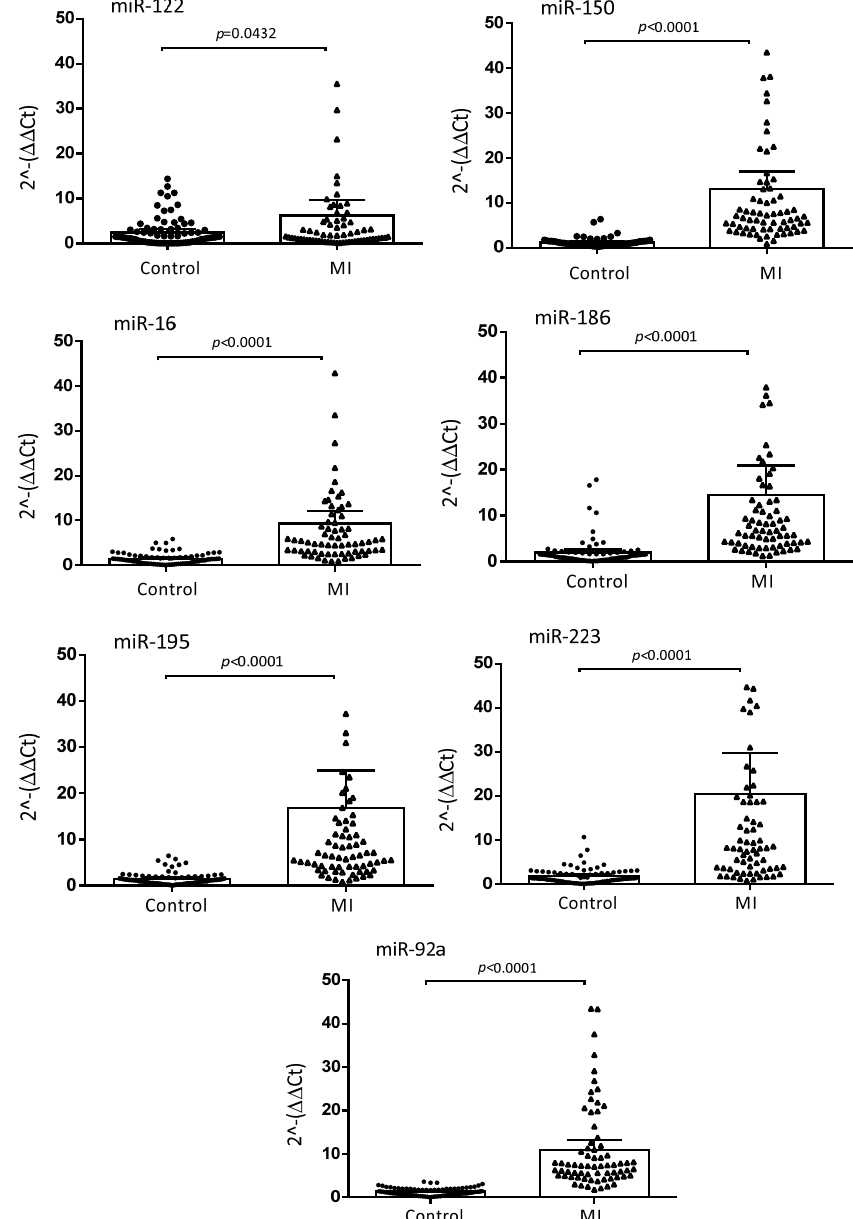
Figure 1. Relative expression of plasma miRNA levels in MI and control populations. The ΔΔ Ct method was used to quantify the relative miRNA expression of miR-122, miR-150, miR-16, miR-186, miR-195, miR-223 and miR-92a. Ct values were normalized to cel-miR-39-3p and cel-miR-39-5p and the relative expression of the miRNAs was calculated by the 2 −ΔΔ Ct , − [Ct(miRNA target) − (meanCt(miRNA control))] method. Data are presented as means with 95% CI (CI; confidence interval). p values were calculated with the Wilcoxon–Mann–Whitney test.